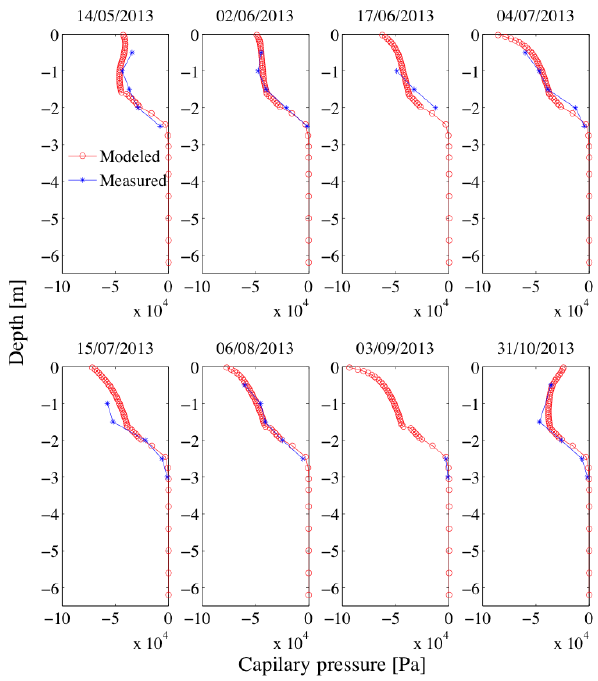
Figure 5. Comparison of the measured and modeled matric poten- tial data for all measurement occasions. The red symbols repre- sents the modeling results obtained from the coupled hydrological- thermal-geophysical inversion. The blue symbols denote the mea-